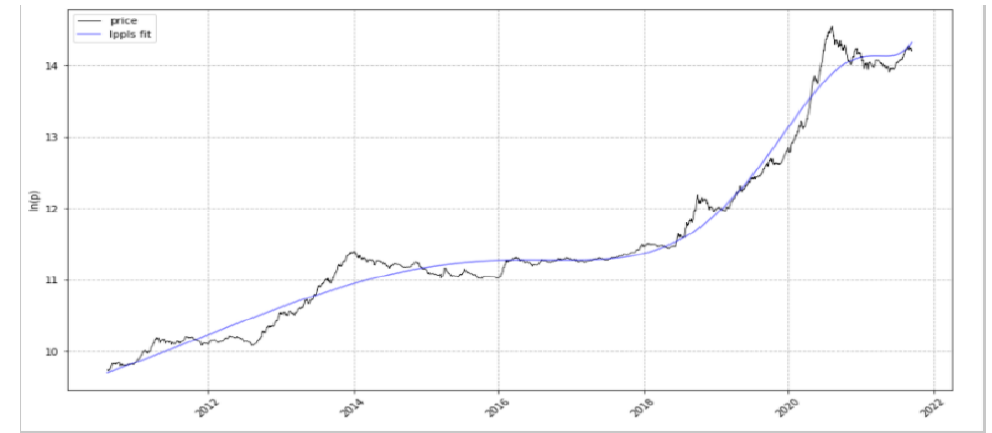
Figure 1, the fitting of LPPLS model on TEDPIX